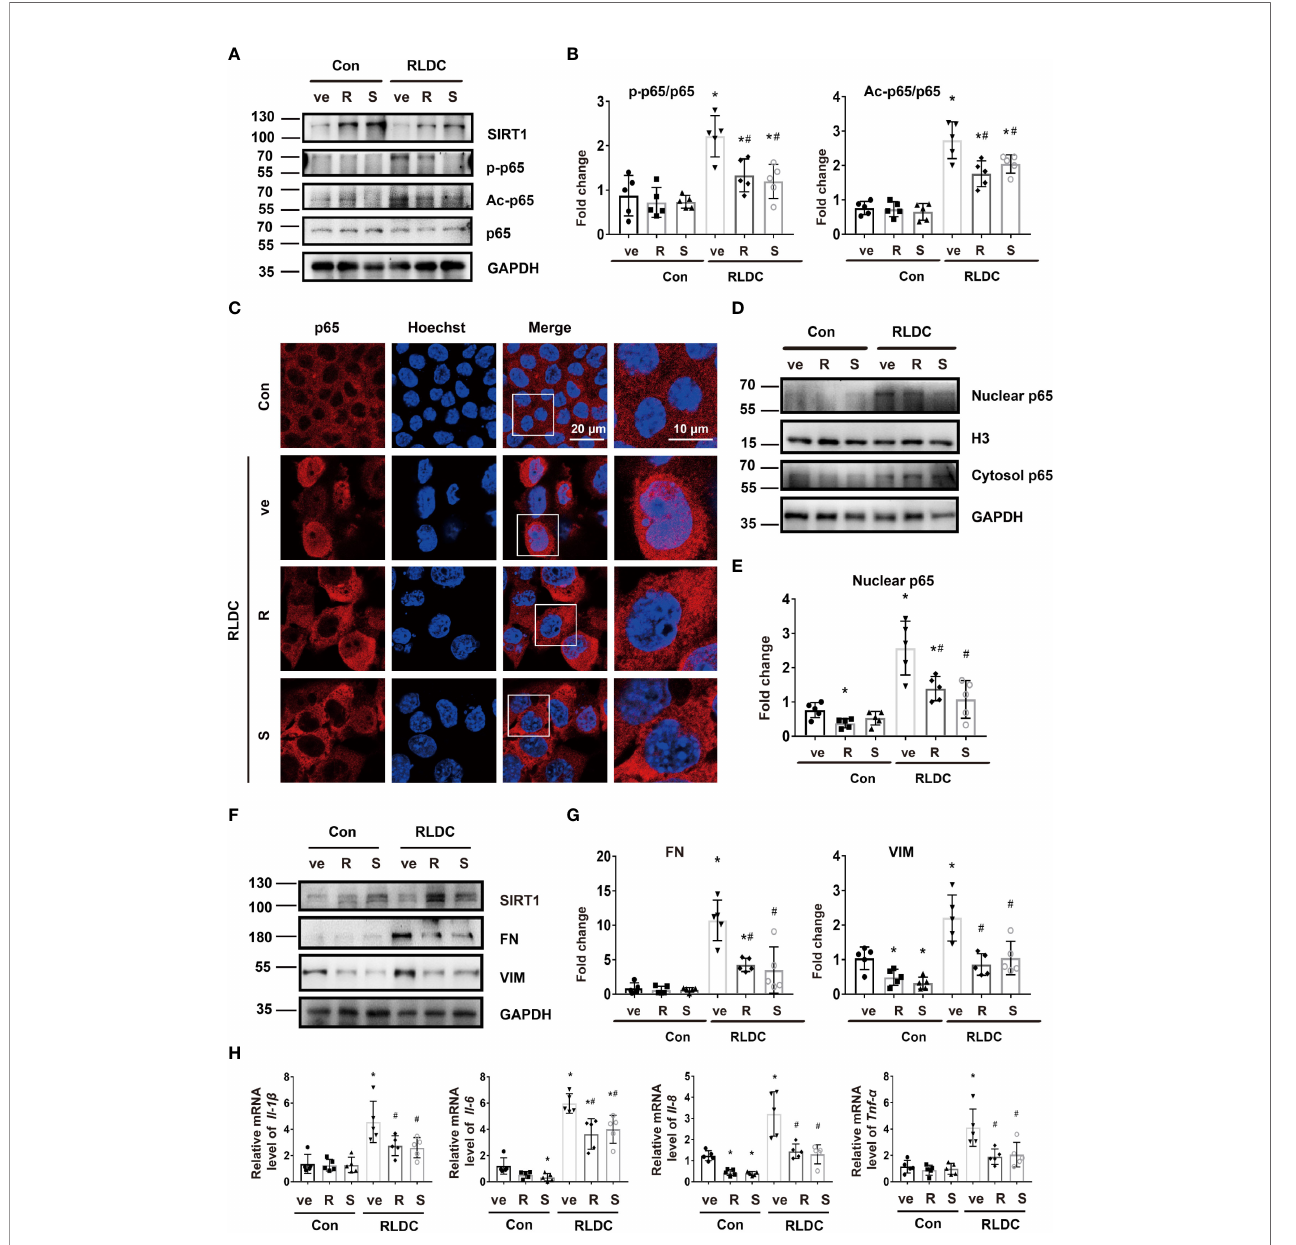
FIGURE 5 | SIRT1 ameliorates fi brotic and in fl ammatory phenotypes in RLDC-treated cells. BUMPT cells were incubated with 2 m M cisplatin for 7h each day for 4 days, and then treated with 20 m M resveratrol (R), 2.5 m M SRT1720 (S), or vehicle solution (ve) for 17h in cisplatin-free medium to collect samples for analysis. (A) Immunoblot of SIRT1, p-p65, Ac-p65 and p65 of total protein extracted from cells (n=5). (B) Semi-quantitative analysis of immunoblot of SIRT1, p-p65, and Ac- p65. (C) Immuno fl uorescence analysis of nuclear translocation of p65. Images were collected by laser-scanned confocal microscopy. (n=5). (D) Immunoblot analysis of nuclear and cytosolic p65 (n=5). The cells were fractionated into nuclear and cytosolic fractions for immunoblot analysis of p65. H3 and GAPDH were used as internal controls for nuclear and cytosolic fractions, respectively. (E) Densitometry of nuclear p65. The protein level of control group was arbitrarily set as 1, and the signals of other conditions were normalized with the control group to indicate their protein fold changes. (F) Representative immunoblots of SIRT1, FN, VIM and GAPDH (loading control) of total protein extracted from cells (n=5). (G) Densitometry of FN, VIM. The protein level of control group was arbitrarily set as 1, and the signals of other conditions were normalized with the control group to indicate their protein fold changes. (H) mRNA levels of Il-1 b , Il-6, Il-8, Tnf- a were quanti fi ed by qRT-PCR (n=5). Data are normalized to Gapdh and expressed as fold change compared to controls. * P <0.05 vs . the control group (Con + ve), # P < 0.05 vs . RLDC with vehicle solution group (RLDC +